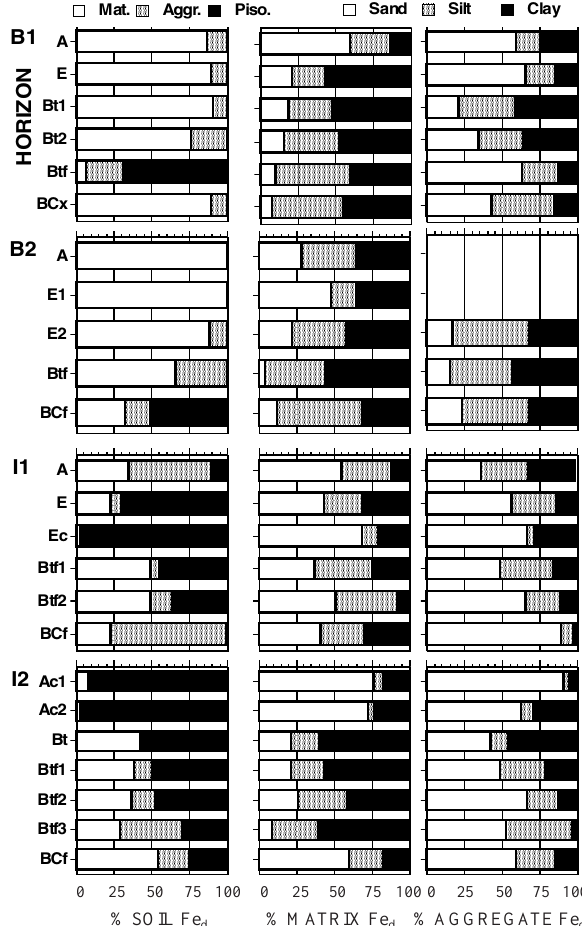
Figure 1. Distribution of Fe among the three d consistency fractions and among the particle size fractions of the matrices and water-stable aggregates. Note that the horizontal scale is identical for all graphs and the legend for consistency fractions applies only to graphs in the first column.